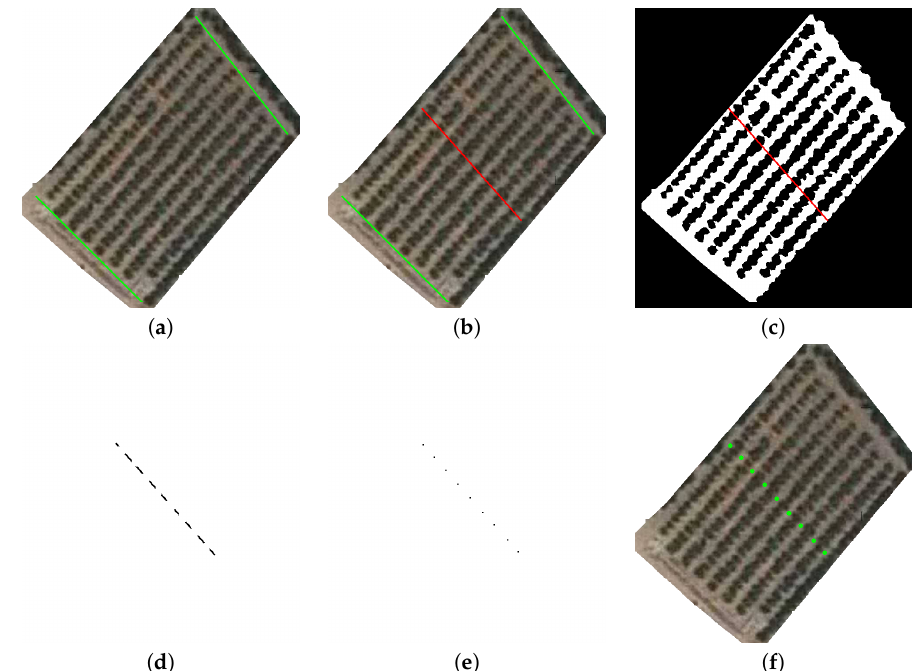
Figure 8. Extracting reference points: ( a ) determining path row lines perpendicular to tree rows, ( b ) determining bisection between path row lines, ( c , d ) intersection between bisection and the Path binary map, and ( e , f ) new reference points and its representation on the parcel satellite image.